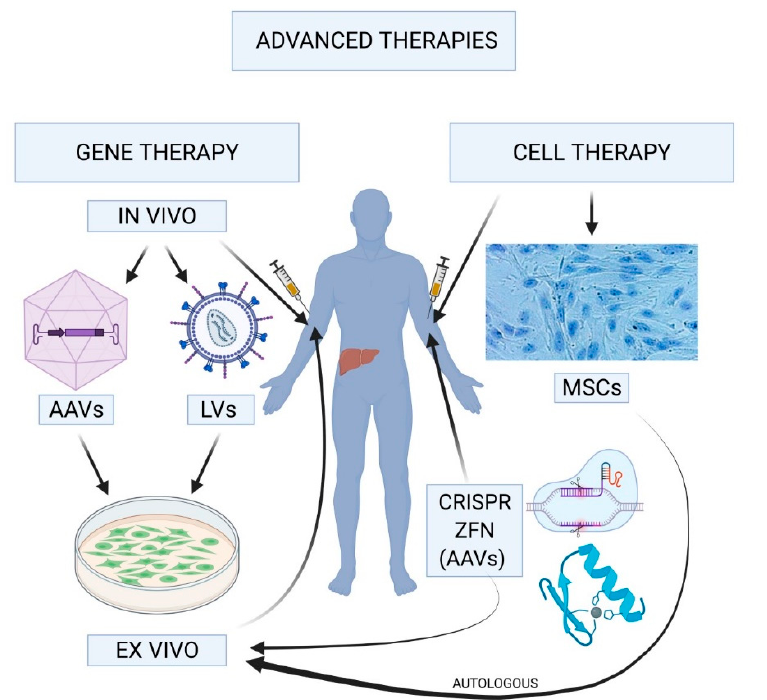
Figure 1. Advanced therapy strategies. In vivo gene therapy where the (typically organ-specific) adeno-associated viral (AAVs) or lentiviral (LVs) vectors carried by the “therapeutic gene” are administered systemically to the patient. In ex vivo gene therapy, autologous or allogenic cells are transfected in vitro and infused back into the patient following their expansion in the culture medium. Cell therapy uses stem cells, or already differentiated cells, transfected or otherwise, to correct a deficiency in the patient’s physiological function. Another alternative is to correct the defective genes responsible for the disease. To do that, several gene-editing tools are available such as CRISPR/Cas9 or ZFNs (zinc finger nucleases). Adeno-associated viral vectors are used to insert guide RNAs and other components necessary to the correction. MSCs, mesenchymal stem cells. (Created with Biorender.com).